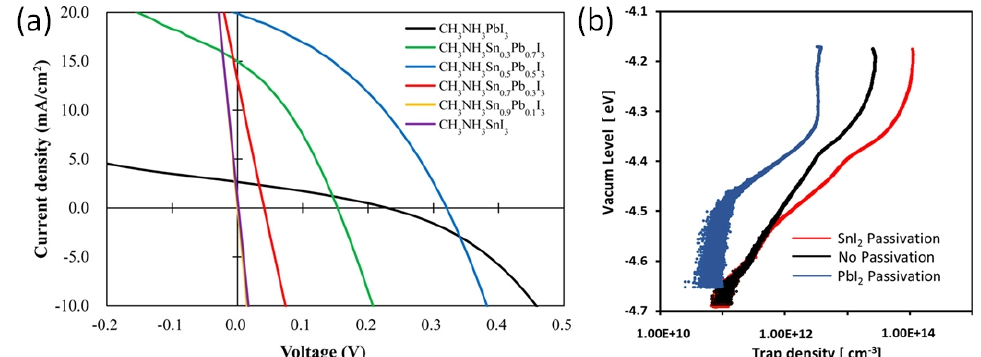
Figure 11. ( a ) Short − circuited J − V characteristics of MASnI 3 photoactive layer-based normal structure solar cell (purple color), reprinted with permission [71]. Copyright 2014, American Chemical Society. ( b ) Trap density evaluation of TiO 2 layer passivated by SnI 2 and PbI 2 . reprinted with permission [73]. Copyright 2020, American Chemical Society.